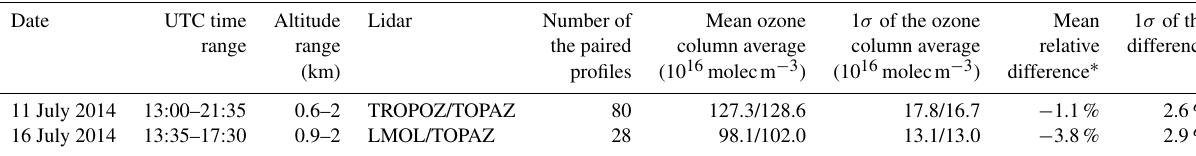
Figure 1. Comparisons of ozone measured by TROPOZ and TOPAZ. (a) Ozone number densities measured by TROPOZ. (b) Ozone number densities measured by TOPAZ. (c) Their relative percent differences, (TROPOZ − TOPAZ)/TOPAZ. (d) Column averages measured by the TROPOZ and TOPAZ as well as their 1 σ standard deviations. TROPOZ measures 1 . 1 ± 2 . 6% lower ozone column average than TOPAZ. Table 3. Comparisons of the ozone column average measured by TROPOZ, TOPAZ, and